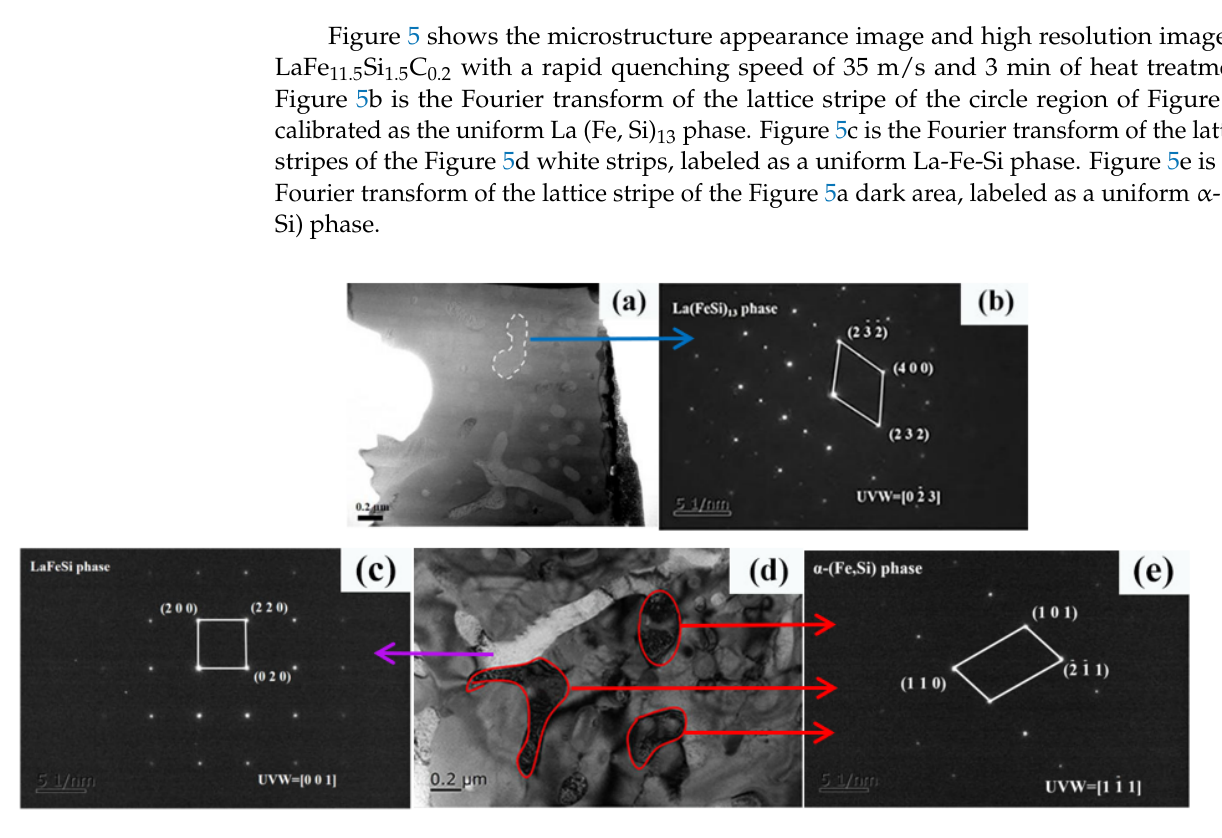
Figure 5. Selected area electron diffraction of LaFe 11.5 Si 1.5 C 0.2 ribbons after heat treatment for 3 min. ( a ) Display of selected area in TEM; ( b ) Fourier transform at the SAED of Figure 5a; ( c ) Fourier transform at the SAED of Figure 5d white strips; ( d ) display of selected area in TEM; ( e ) Fourier transform at the SAED of Figure 5.